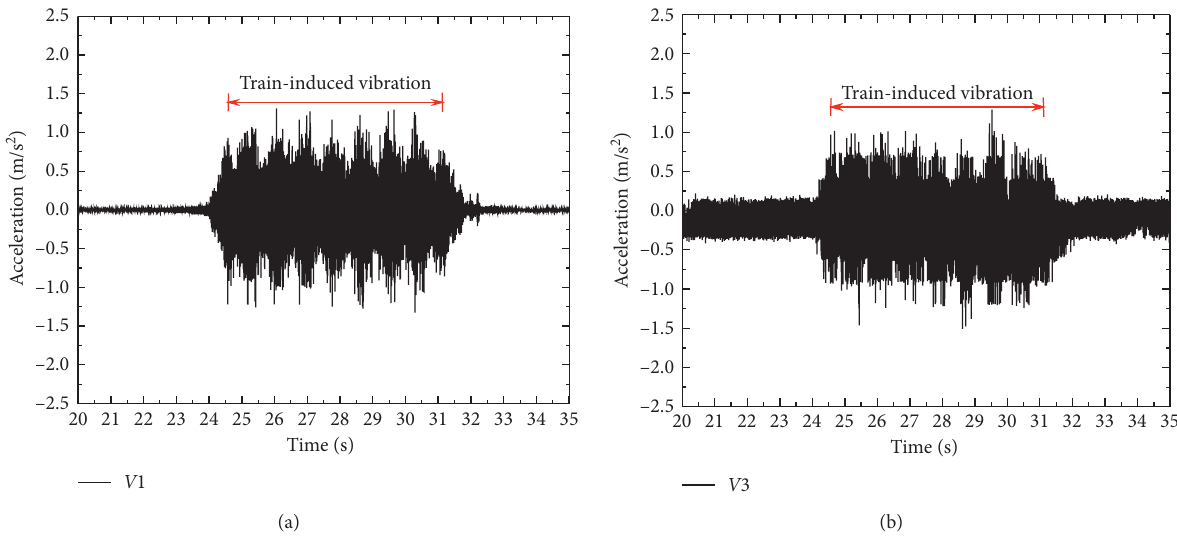
Figure 4: Vibration time histories for points (a) V 1 and (b) V 3 on the steel arch ring.